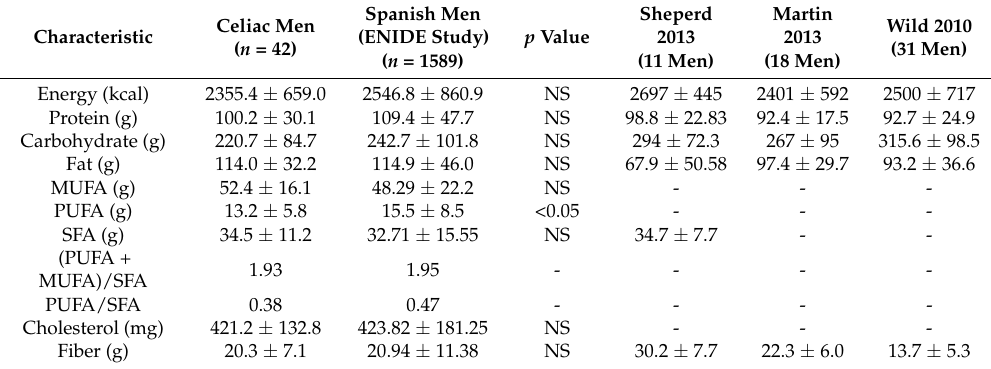
Table 2. Energy and nutrient distribution in celiac and Spanish control men and results from recent studies. Characteristic